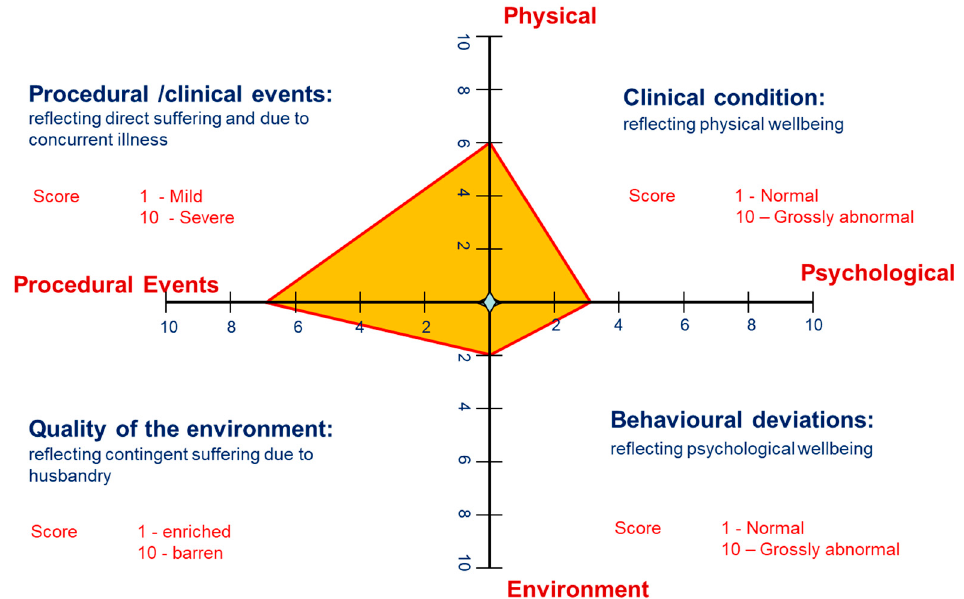
Figure 1. An example of the AWAG showing the four parameters scored on the cruciform grid. In this example, the scores for each parameter are as follows: physical 6; psychological 3; procedural events 7; environment 2. The cumulative welfare assessment score would be calculated from the area of the grid.